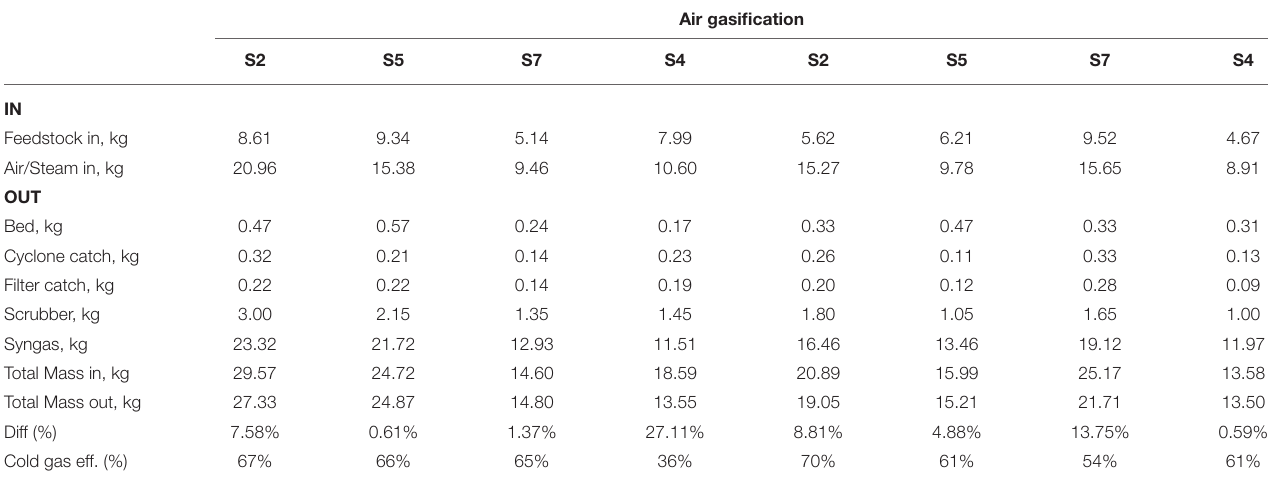
TABLE 5 | Mass balances (kg) for air